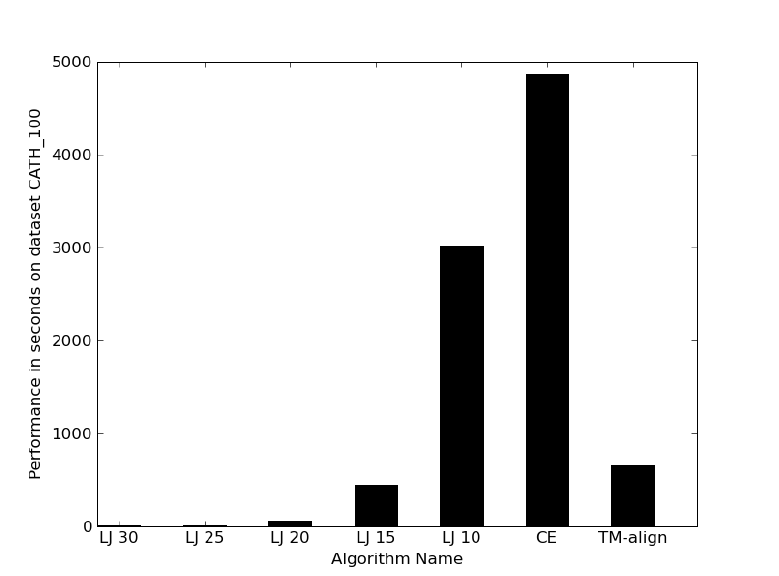
Figure 4. An informal diagram showing the steps performed when a query structure is searched against a set of target structures in an